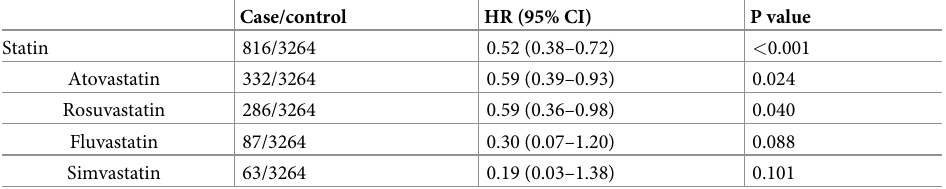
Table 3. Adjusted hazard ratios of different statins for 30-day mortalities of cirrhotic patients with bacterial infections, compared to non-statin users.